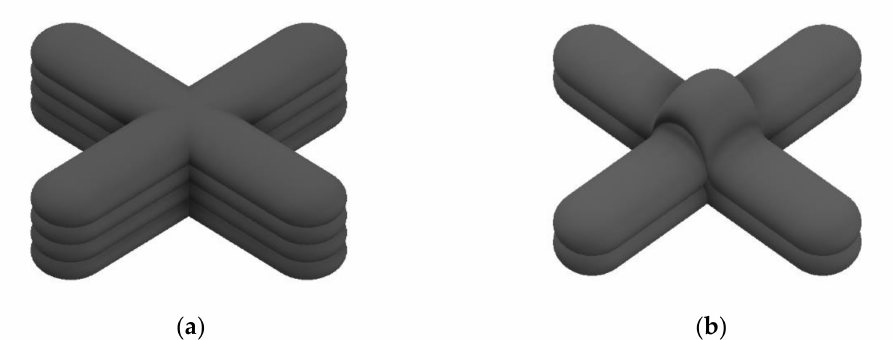
Figure 1. Designs of intersection parts: ( a ) ideal model of deposition products with intersection paths, ( b ) deposit failure that occurs when the deposition process neglects the overlap of the bead by the manufacturing characteristics.